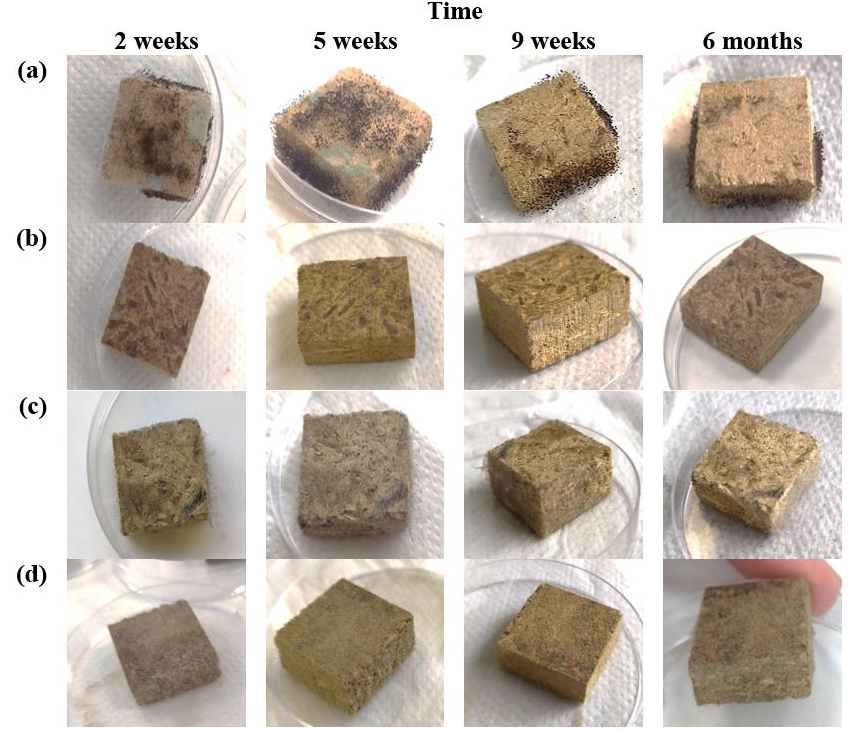
Figure 3. The surface appearance of HS- and CS-based biocomposites impregnated with different oils after 2 weeks, 5 weeks, 9 weeks, and 6 months: ( a ) control samples without linseed oil; ( b ) samples with linseed oil; ( c ) control samples without tung tree oil; ( d ) samples with tung tree oil.